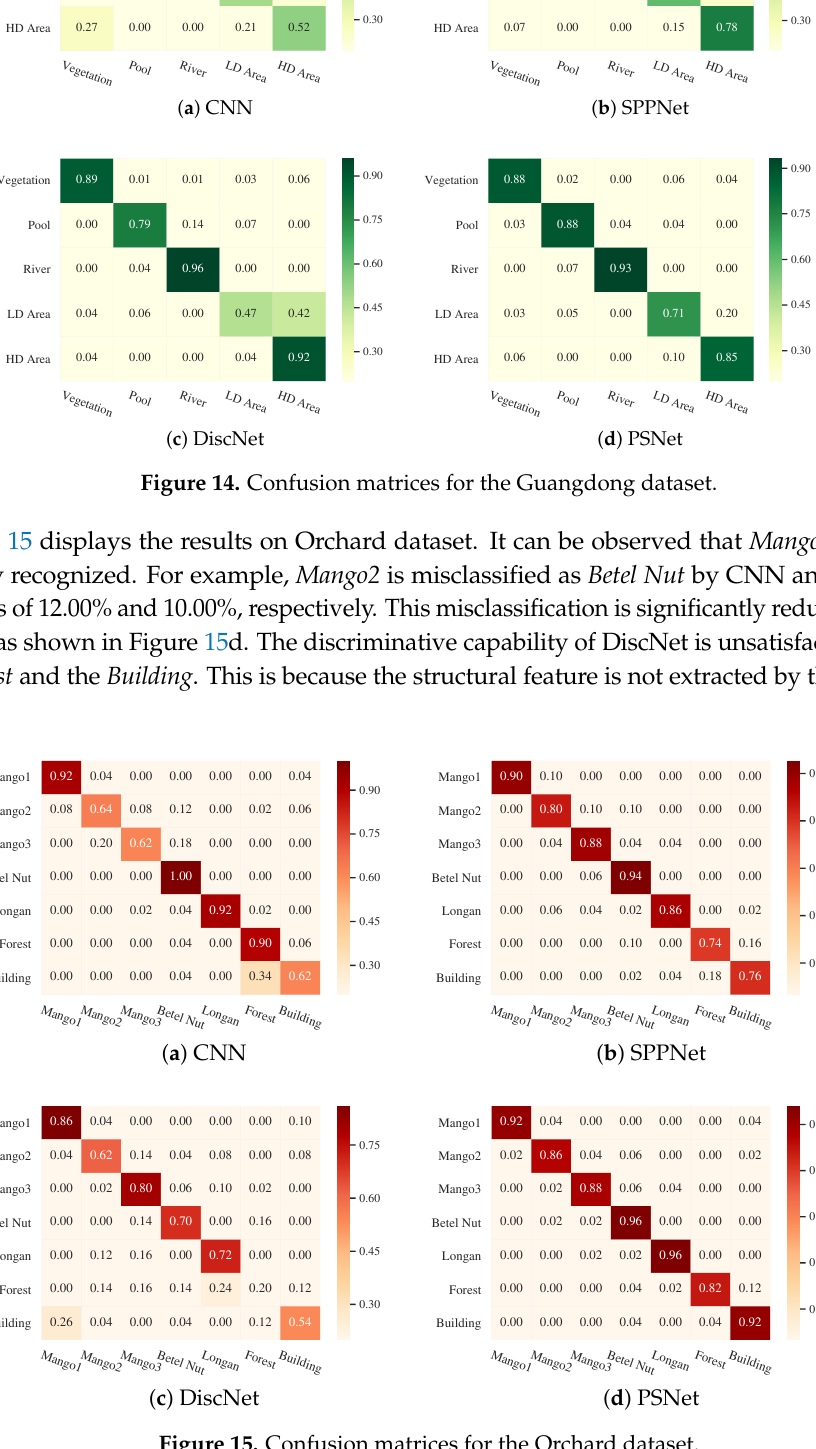
Figure 15. Confusion matrices for the Orchard